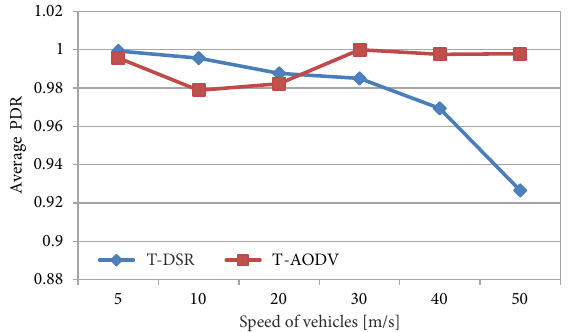
0.880.90.920.940.960.9811.02 Figure 11. Average PDR for T-DSR and T-AODV Figure 12. Average end-to-end delay for T-DSR and T-AODV Figure 13. Simulation of real traffic scenario using SUMO